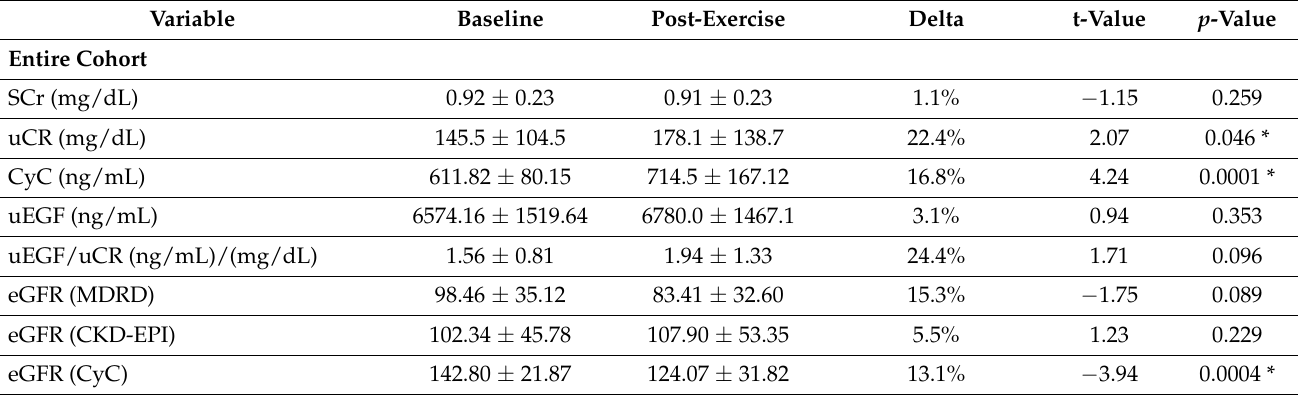
Table 2. Changes in concentrations and estimates of renal health and function